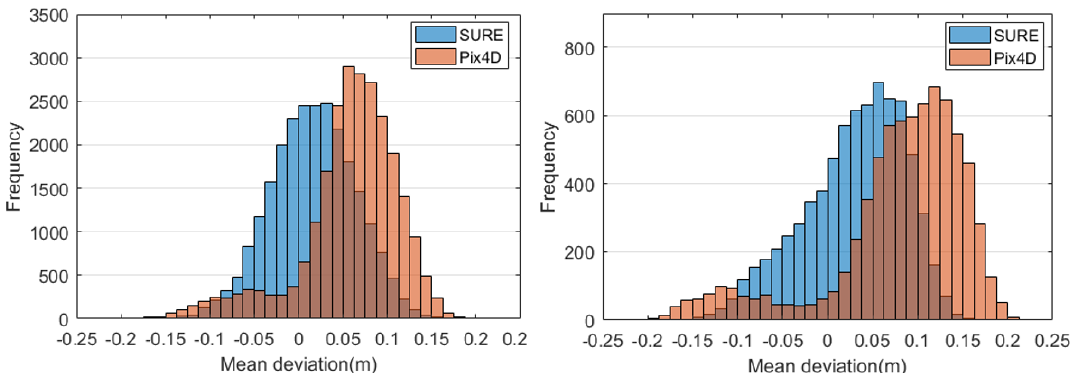
Figure 8. Distribution of mean deviations for the DIM points generated by Pix4D and SURE. Left: 24,634 ground patches; (b) 7381 grassland patches. Note that the dark brown between the blue and light brown histograms is actually the overlapping of the two histograms.